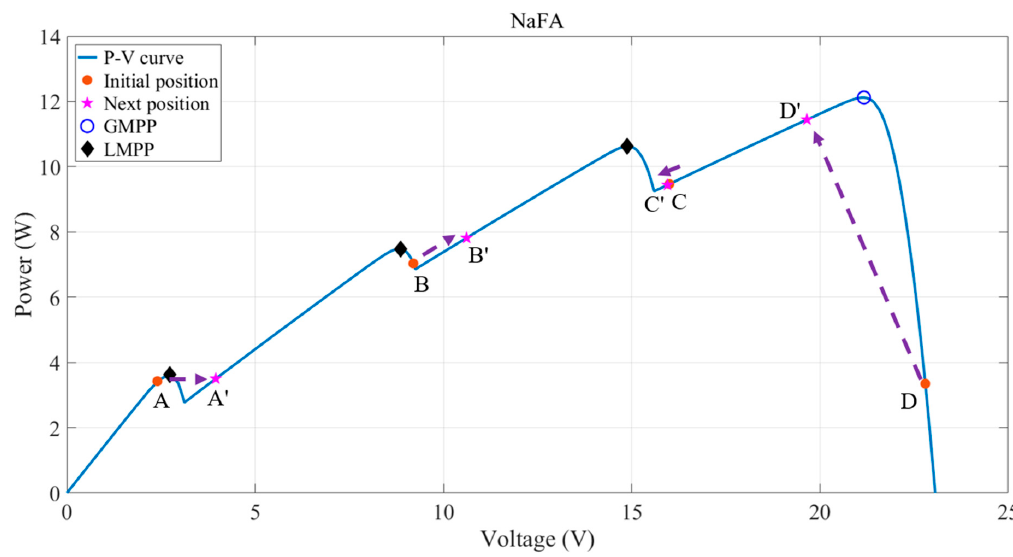
Figure 6. Adjustment of operating points along the P - V curve of a PV array under PSCs with the firefly algorithm with neighborhood attraction (NaFA).